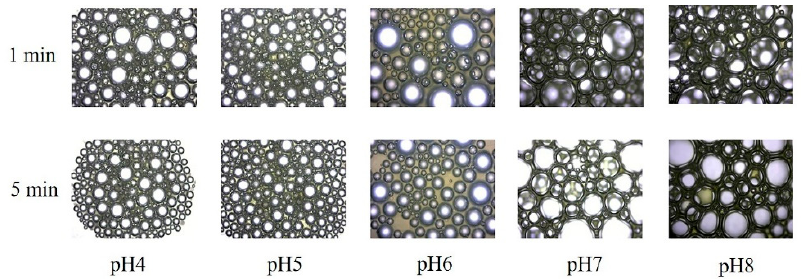
Figure 2. Time evolution of air bubbles formed by rhamnolipid fermentation broths with pH 4–8. All images were obtained at the same magnification.